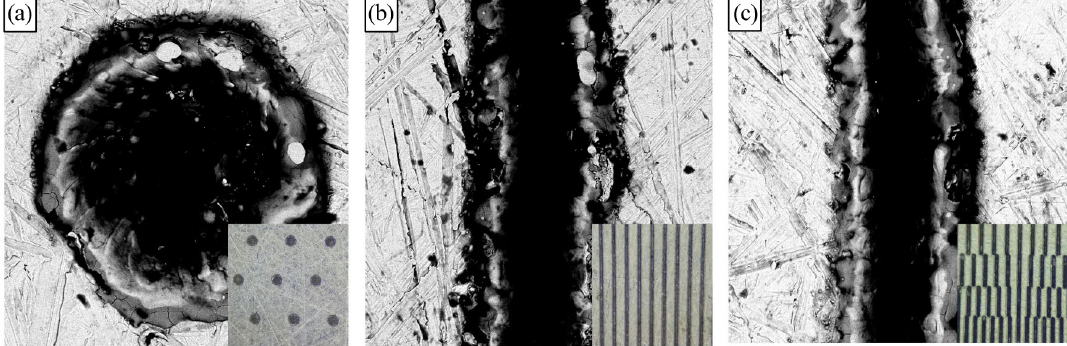
Fig. 3 SEM images of textured guiding surface: (a) DB, (b) GB, and (c)